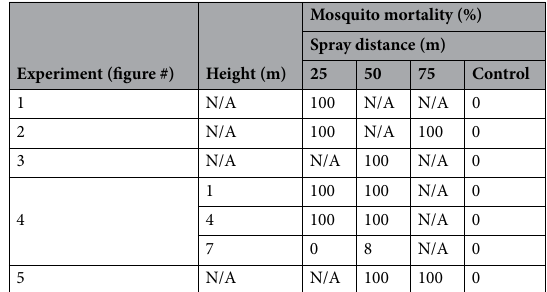
Table 1. Percent mortality per cage of adult female Ae. aegypti mosquitoes held in cages (N = 25 per cage) at various heights and/or distances 12 h after exposure to malathion ULV spray application.